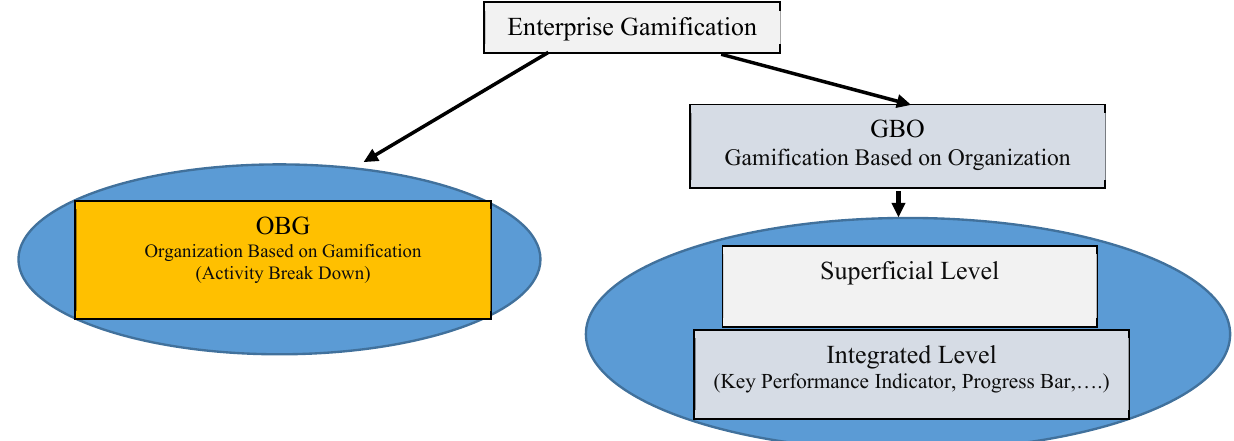
(Key Performance Indicator, Progress